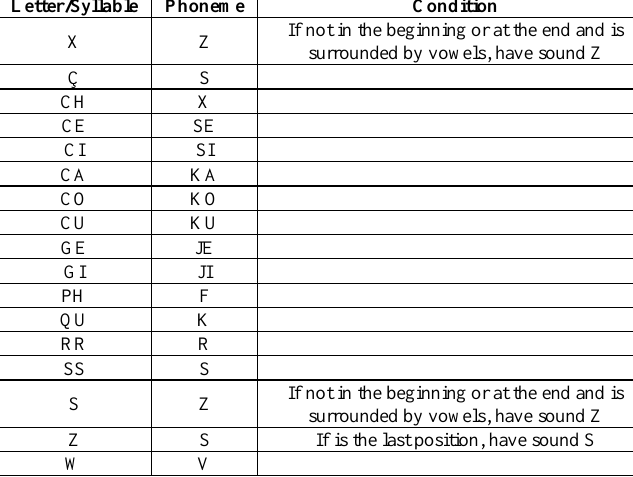
Table 2: Portuguese language phonetic transcriptions.